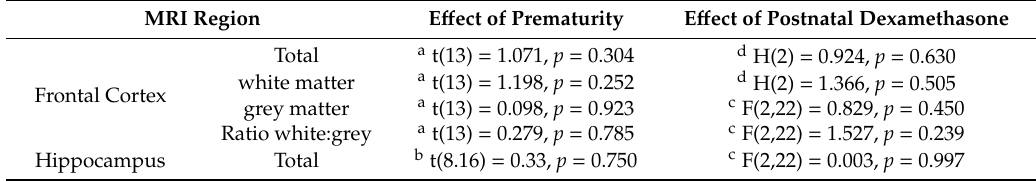
Table 2. Statistical analysis of volumetric measures obtained from MRI.